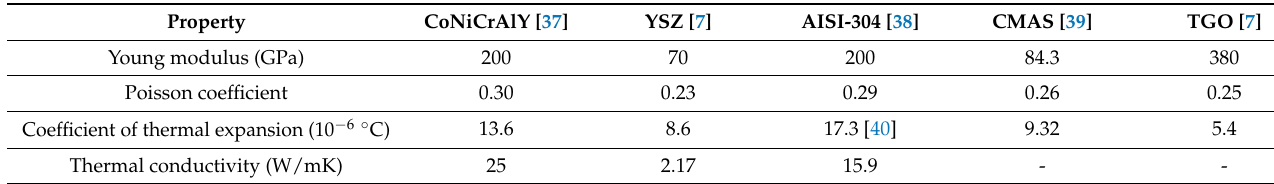
Table 3. Physical properties of the TBC